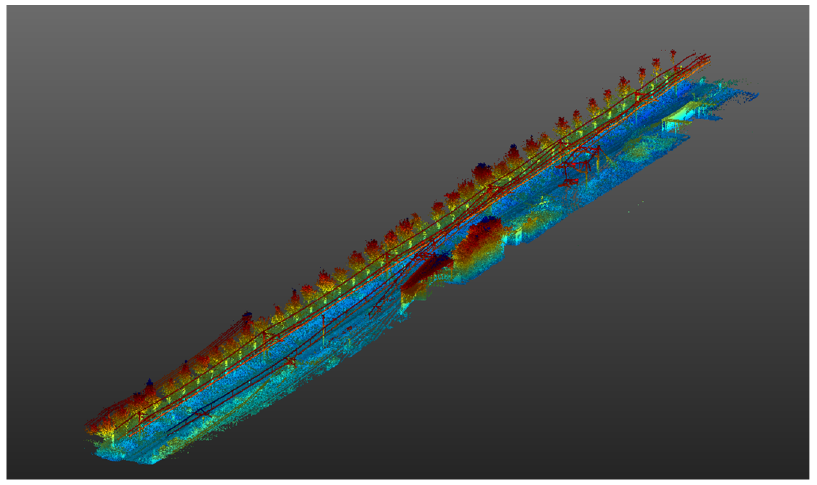
Figure 17. 3D point cloud effect of the railway.